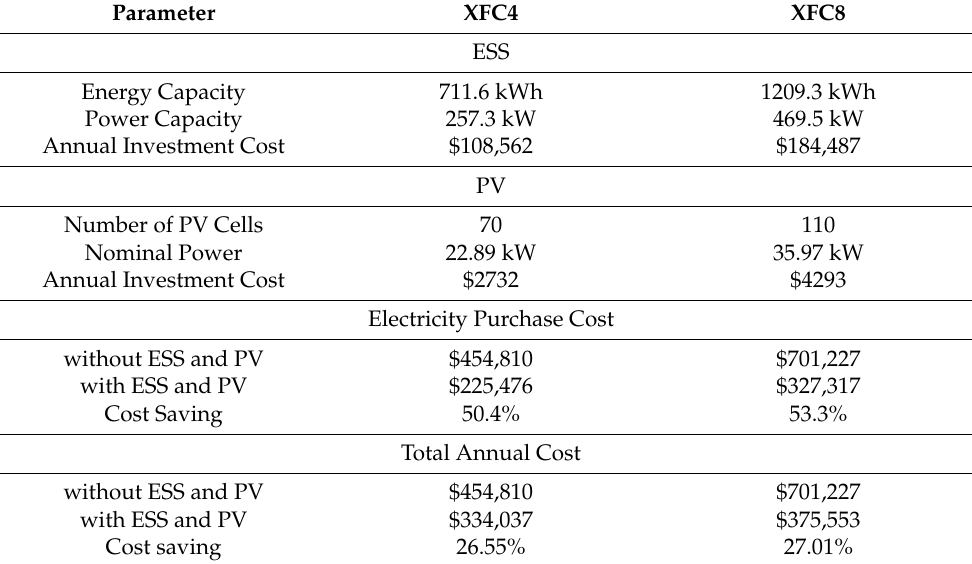
Table 5. Benefit to Two XFC Stations.